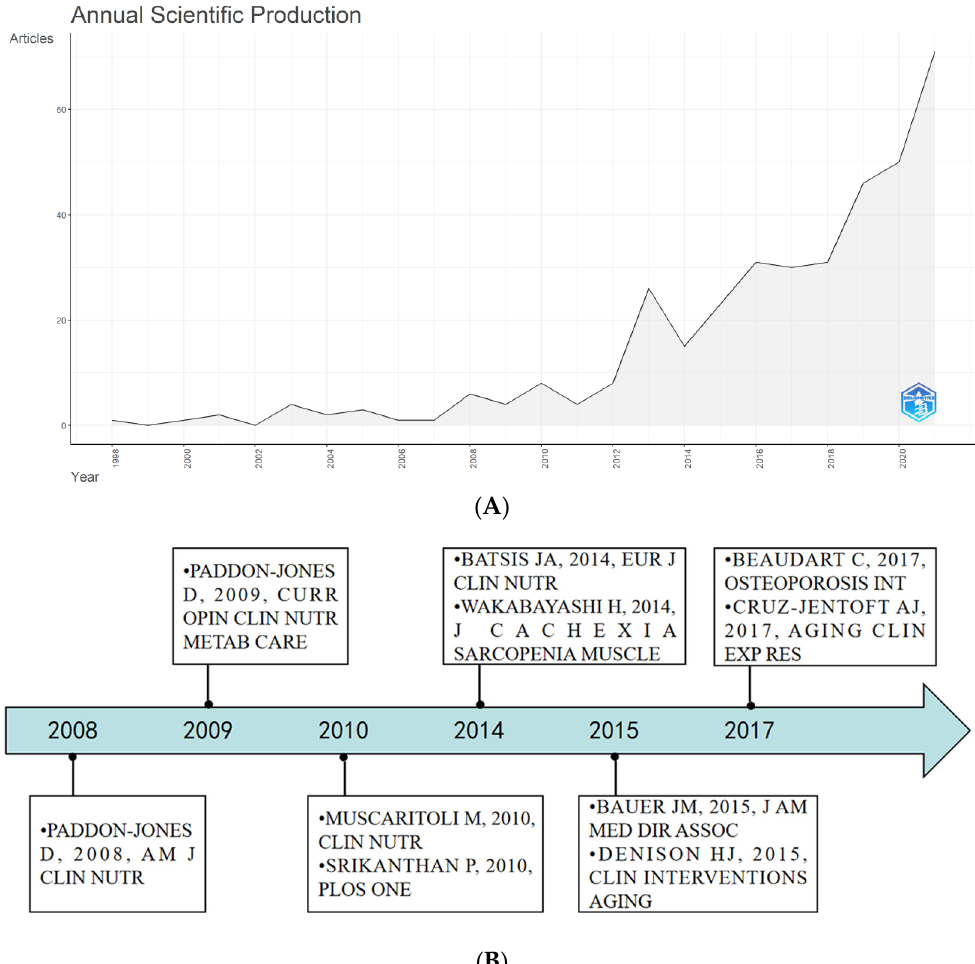
Figure 2. ( A ) The number of nutrition research works on sarcopenia. ( B ) Timeline of the top 10 cited documents. cited